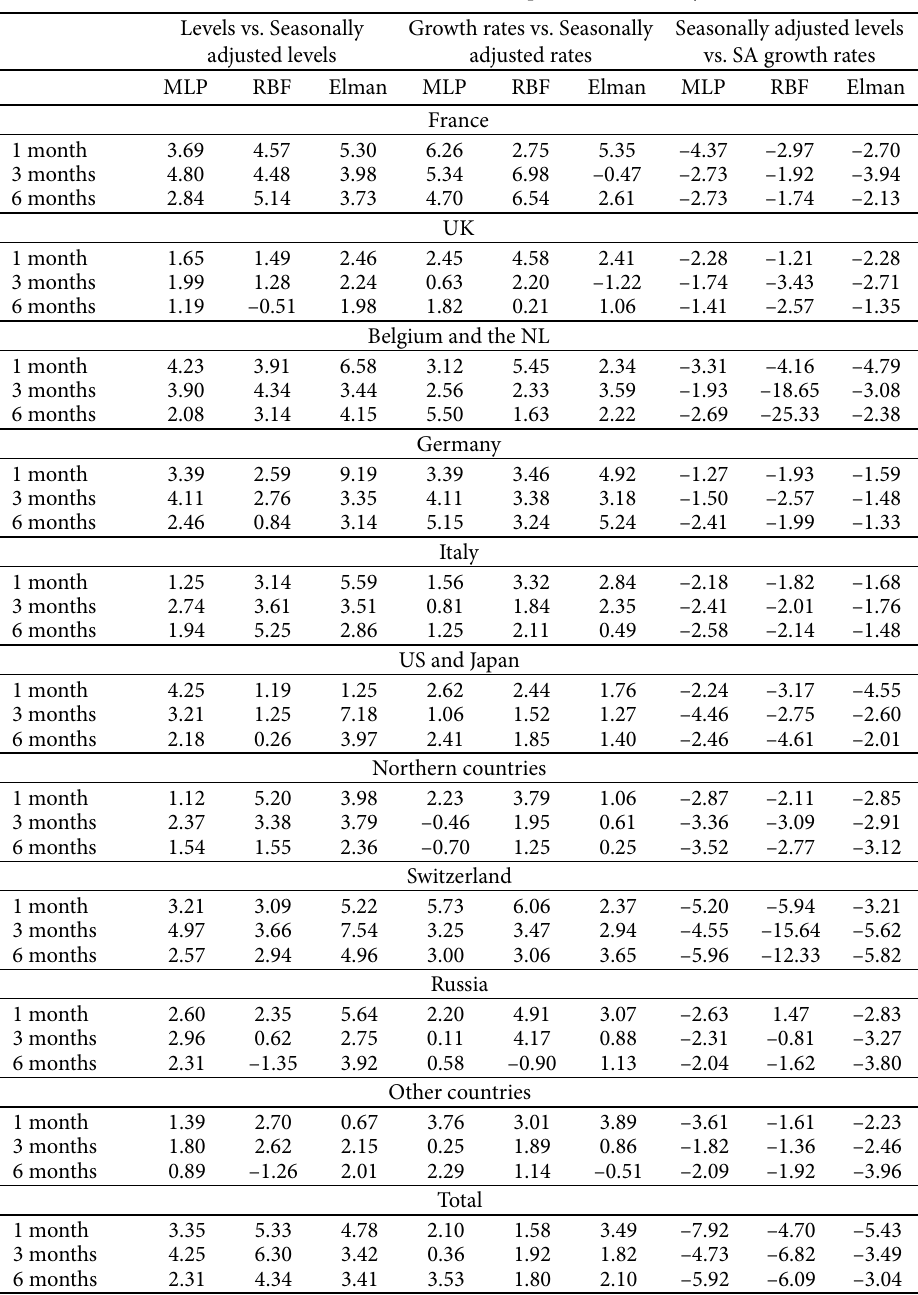
Table 6. Diebold-Mariano loss-differential test statistic for predictive accuracy Levels vs.